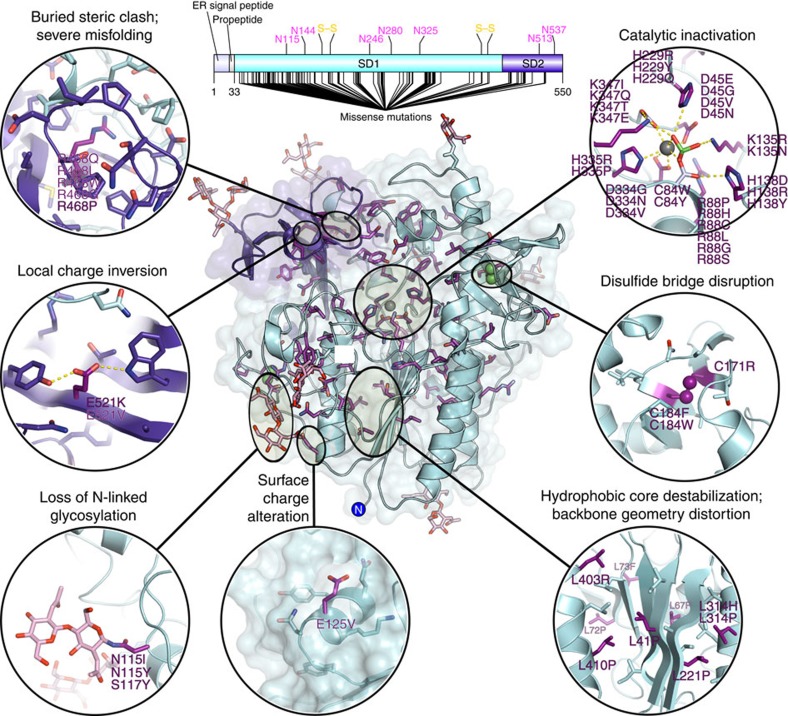
Disease-associated mutations of IDS.(Top) Annotated diagram of the IDS protein, indicating positions of all known Hunter syndrome missense mutations. All residues that are mutated are shown as sticks (purple) on the structure of IDS, coloured as above. Different mutations have different consequences; for a selection of these a more detailed view is provided (Insets) showing the surrounding region of the structure that is perturbed.